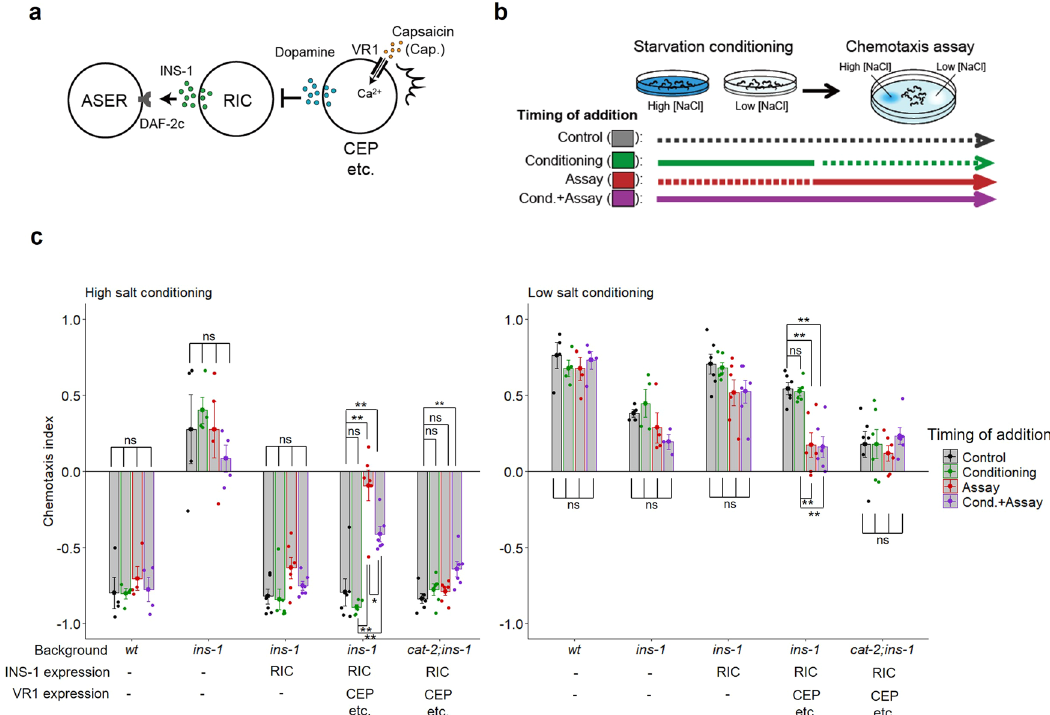
Fig. 2 INS-1 release during salt chemotaxis but not during starvation conditioning is required for taste avoidance learning. a INS-1::Venus and VR1 were expressed in RIC under the tbh-1 promoter and in dopaminergic neurons, including CEP, under the dat-1 promoter, respectively, and then capsaicin was applied to inhibit INS-1 release from RIC with speci fi c timing. b Timing of capsaicin addition during the taste avoidance learning paradigm. Continuous lines and dotted lines denote with and without capsaicin, respectively. c Chemotaxis of wild type, ins-1(nr2091) or cat-2(e1112); ins-1(nr2091) mutant worms with or without transgenes that drive expression of INS-1::Venus or both INS-1::Venus and VR1. Starvation conditioning was performed at high (left) or low (right) salt concentrations. Capsaicin was applied only during salt conditioning (green dots), only during chemotaxis test (red dots), or during both (purple dots). n = 4 – 6 assays. Bars represent mean values; error bars represent SEM. ANOVA with Tukey ’ s post hoc test: ** P < 0.01. ns not signi fi conditioned salt concentrations (Fig. 3c, fourth blocks, red bars). whereas strong activation did not occur in response to decreased salt concentration (Fig. 4a left, blue line in top panel, middle panel). After food deprivation for 5 – 6 h with high salt, the OFF response, i.e., calcium response to a decrease in salt concentration, was sig- ni fi cantly enhanced (Fig. 4a left, orange line in top panel, bottom panel, 4b left). We next assessed AIA responses after cultivation at 25 mM (low) salt in the presence of food. The AIA neurons were activated in response to both decreased and increased salt con- centrations, with stronger activation observed in OFF responses (Fig. 4a right, blue line in top panel, middle panel). After food deprivation for 5 – 6 h with low salt, the ON response, i.e., calcium response to an increase in salt concentration, was signi fi cantly enhanced (Fig. 4a right, orange line in top panel, bottom panel, Fig. 4b right). To test the contribution of ASER to these AIA responses, tetanus toxin light chain (TeTx) was expressed in ASER to decrease the synaptic output from the neuron and then the activities of AIA upon salt concentration changes were monitored. We fi rst con- fi rmed that worms expressing TeTx in ASER showed weak but signi fi cant defects in taste avoidance learning (Supplementary Fig. 4). After cultivation at high salt in the presence of food, AIA neurons from TeTx-expressing animals responded to salt con- centration increase in a manner similar to the wild type, suggesting that the ON response of AIA is regulated by neurons other than ASER (Fig. 4c left, blue line in top panel, middle panel). On the other hand, no signi fi cant enhancement was observed in the OFF and ON responses of AIA after food deprivation (Fig. 4c, d). These data suggest that AIA activities in response to salt concentration changes are enhanced after starvation dependent on the output from the ASER neuron.